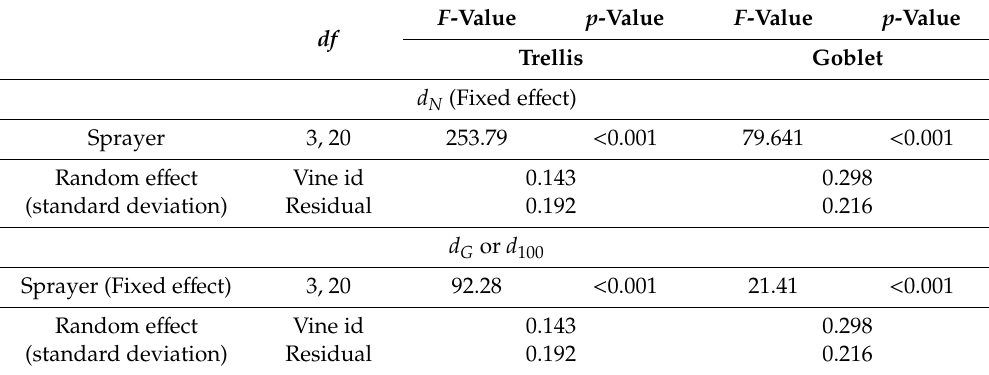
Table 5. The linear mixed e ff ects model results for the e ff ect of the sprayer on d N and d G or d 100 on ground losses for the trellis and goblet training systems. The analysis for d 100 is equivalent to that for d G as the two parameters di ff er only by a divisor of 2.5 (see Equations (3) and (4)). F df